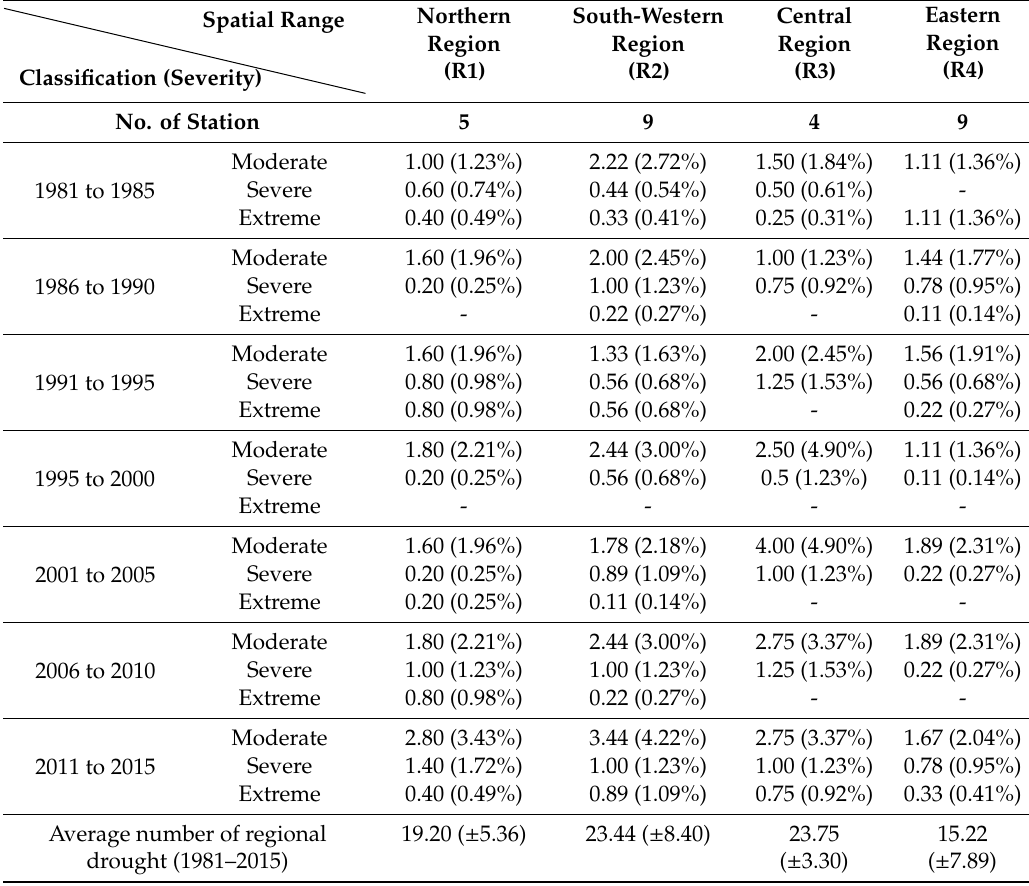
Table 5. Regional drought events by severity in seven quinquennial periods from 1981 to